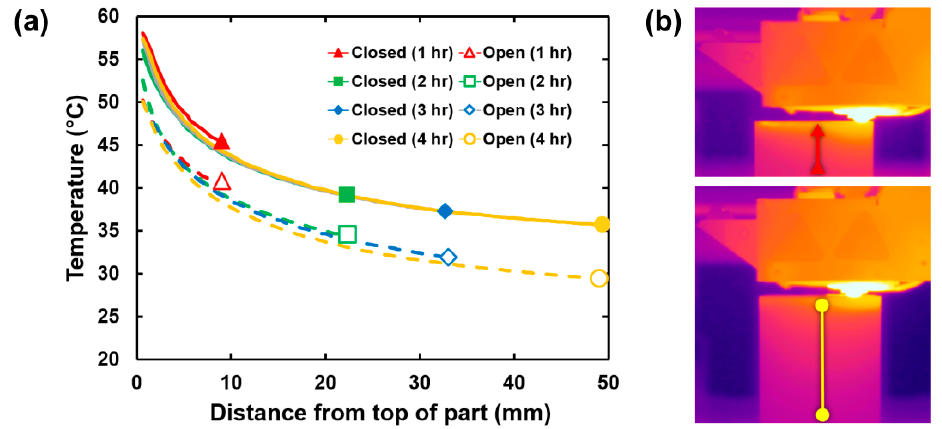
Figure 4. ( a ) Temperature profiles of test part surface with printer visor closed and open. ( b ) Parts are measured from top to bottom using FLIR Tools software. Red and yellow lines correspond to the points on ( a ).